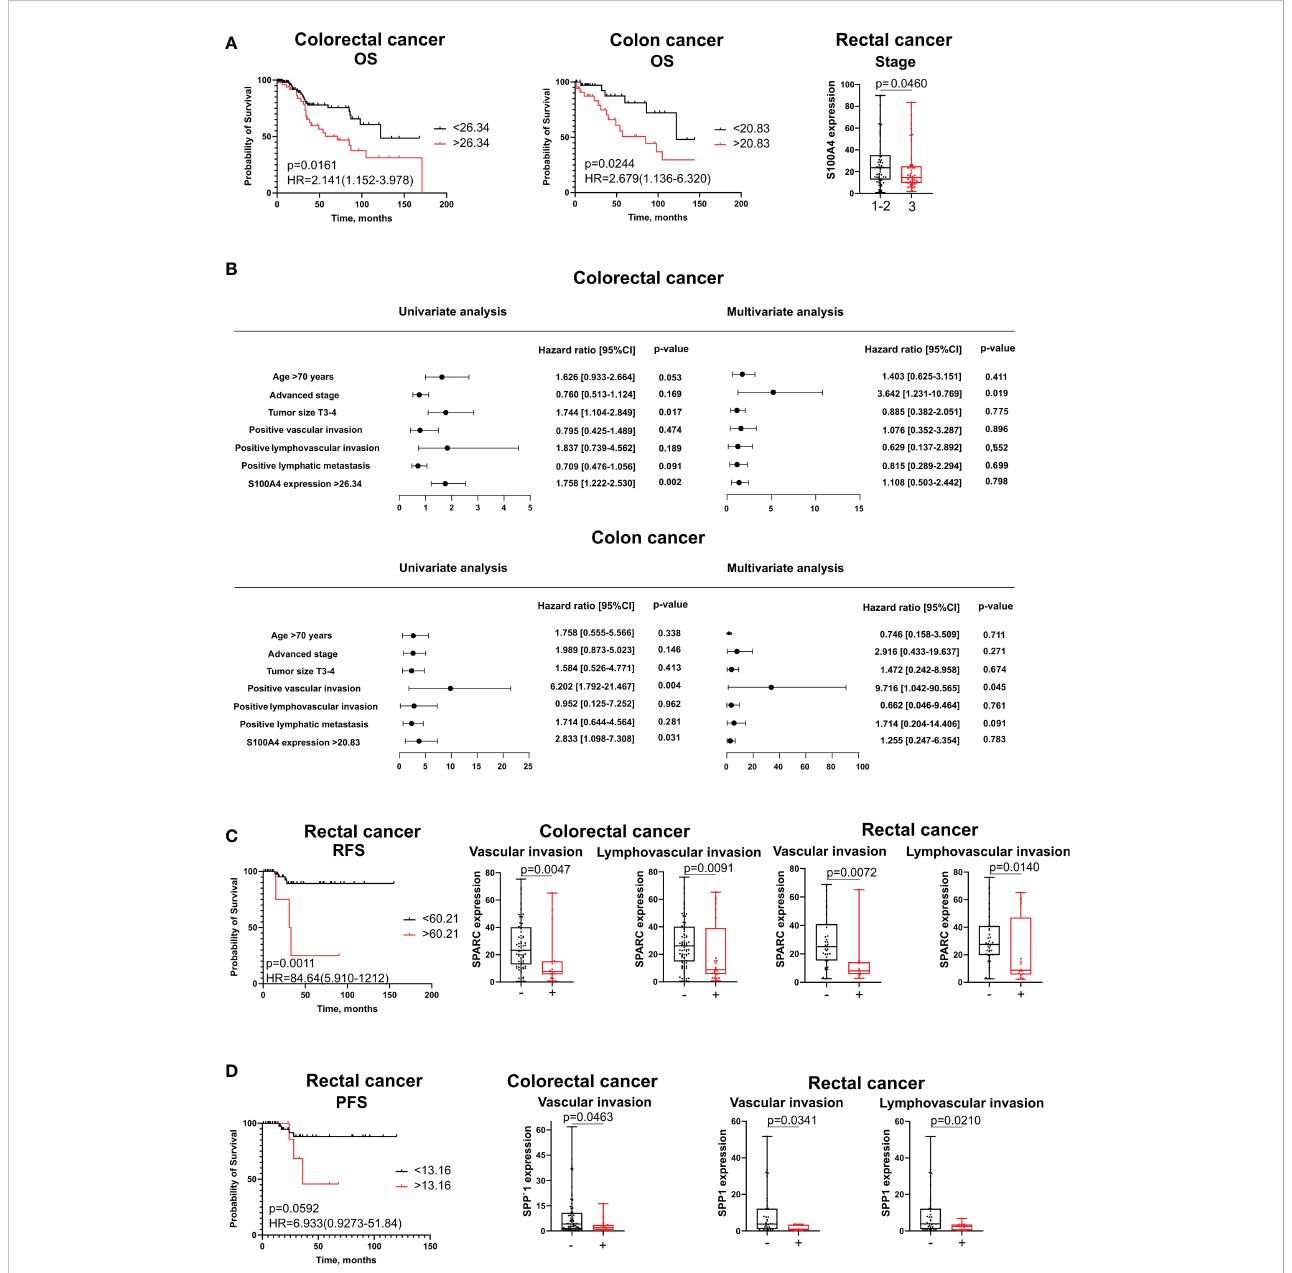
FIGURE 5 The association of stromal expression of S100A4, SPARC and SPP1 with survival and clinical-pathological parameters. (A) S100A4 stromal expression predicts poor OS for CRC patients and colon cancer patients, but is negatively correlated with tumor stage in rectal cancer. (B) The prognostic signi fi cance of S100A4 protein levels for overall survival in patients with CRC and CC revealed by univariate and multivariate COX analysis. (C) SPARC stromal expression is an unfavorable parameter for RFS in rectal cancer patients. SPARC protein expression is negatively associated with clinical- pathological parameters in combined CRC group and in rectal cancer patients. (D) SPP1 stromal expression is unfavorable for PFS in patients with rectal cancer. SPP1 protein expression is negatively associated with clinical-pathological parameters in combined CRC group and in rectal cancer patients. Log-rank test p-values are shown in Kaplan-Meier plots. Mann-Whitney U test was applied for the comparison of two groups. Box plots depict protein expression (min, Q1, median, Q3,